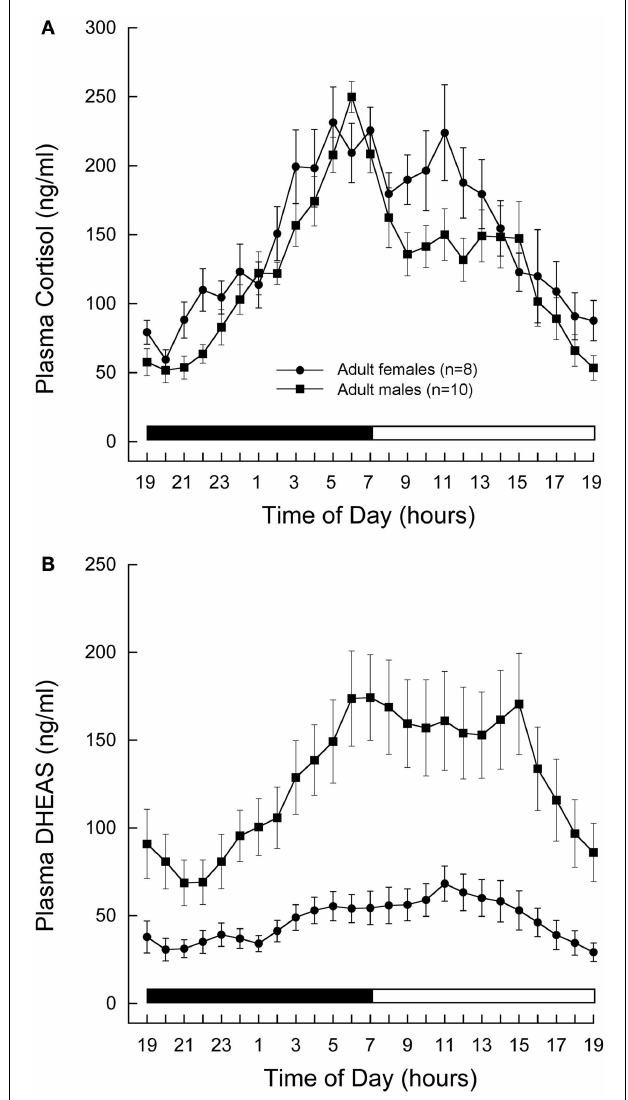
FIGURE 1 |Twenty-four-hour plasma profiles of adrenal steroids in male and female rhesus macaques . Serial blood samples were remotely collected from adult (11–12years) male ( n = 10) and female ( n = 8) animals and assayed for cortisol (A) and DHEAS (B) . Each data point represents the mean and vertical lines indicate the SEM.Time of day is indicated along the abscissa, and periods of darkness and light are represented by black and white bars, respectively. In both sexes, cortisol and DHEAS levels rose gradually during the night and reached peak levels around the time of lights on in the morning. Mean cortisol levels were similar in the two sexes, whereas mean DHEAS levels were significantly higher in males than in females ( P < 0.01, Student’s t